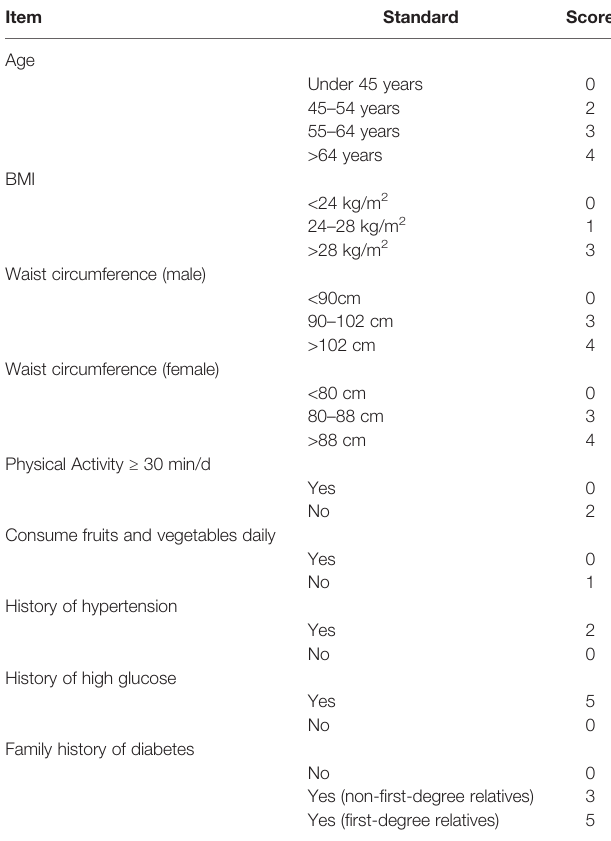
TABLE 1 | Finnish Diabetes Risk Score (FINDRISC)